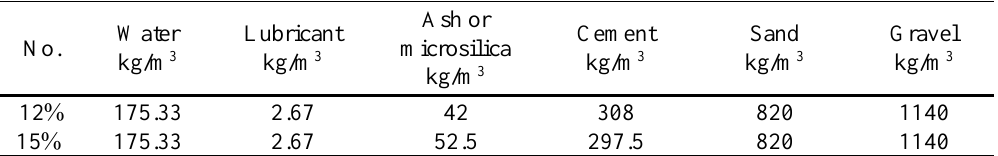
Table 9. Concrete mixing plan containing rice husk ash or microsilica .